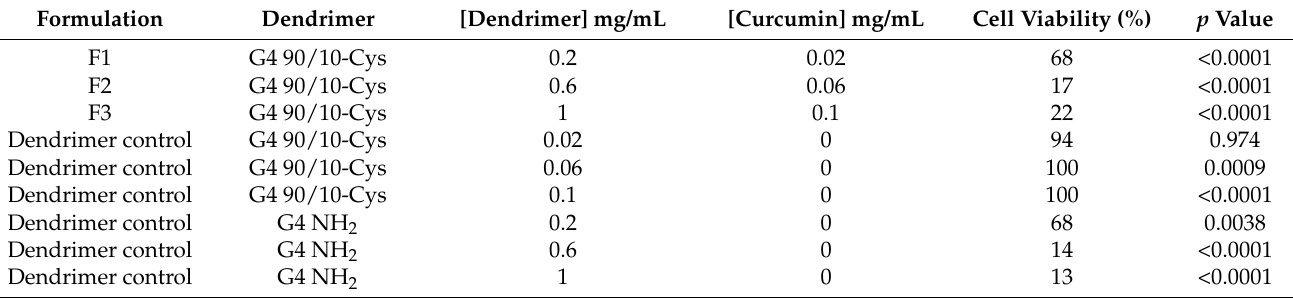
Table 6. Effect of F1, F2 and F3 on GL261 glioblastoma